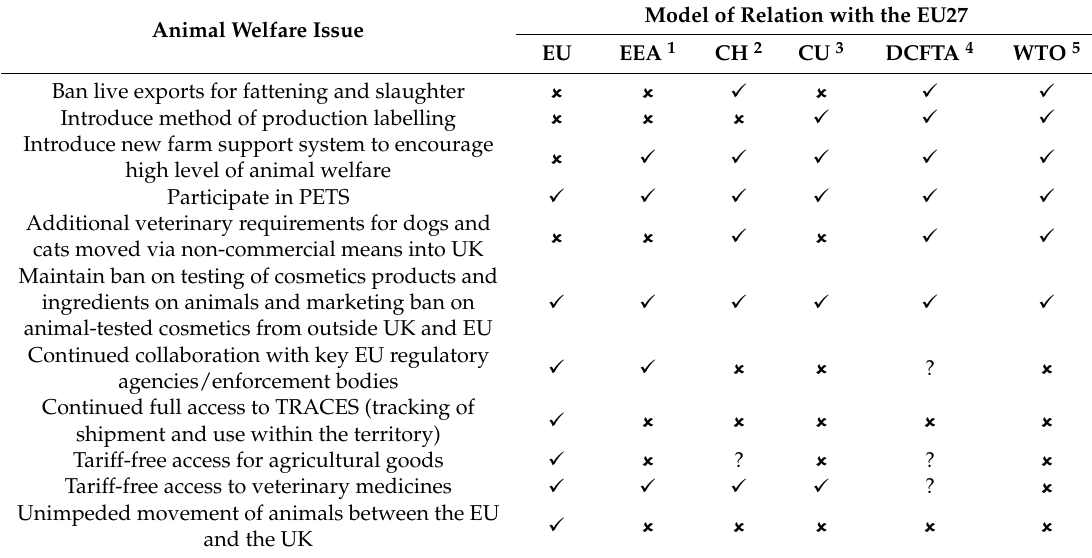
Unimpeded movement of animals between the EU and